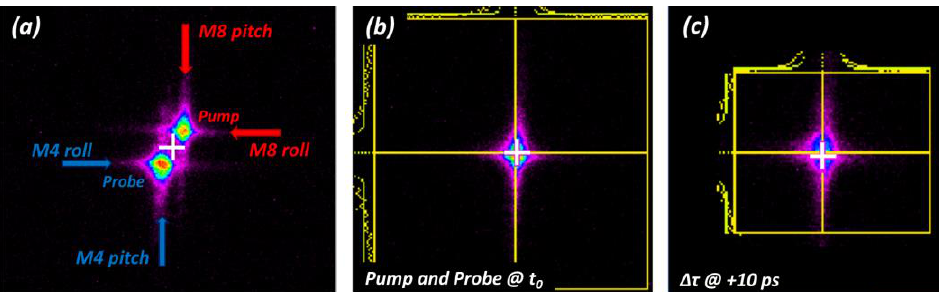
Figure 5. ( a ) Spots at the focal plane in the experimental end-station. To obtain the proper overlap, both pump and probe spots are steered towards their center of mass (white cross target) by acting on the pitch and roll actuators of M4/M8. ( b ) Overlapped spots at t 0 , and ( c ) pump spot position at a delay of +10 ps, operating (on purpose) the feedback without any numerical correction to the effective pointing target. In this case, it is possible to observe a slight offset, more pronounced along the vertical axis, ascribable to residual paraxial errors.